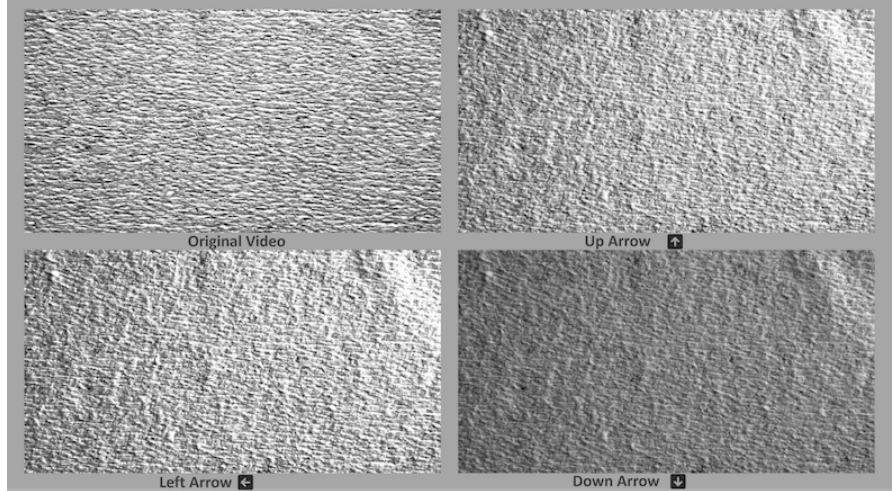
Figure 5. User interface for the psychometric experiment ( S 1 sample). The acquired raw video sequence was presented in the top-left screen zone, and the three other areas were dedicated to the rendering videos using the three tested approximation models (PTM, HSH, and DMD), which were randomly positioned.